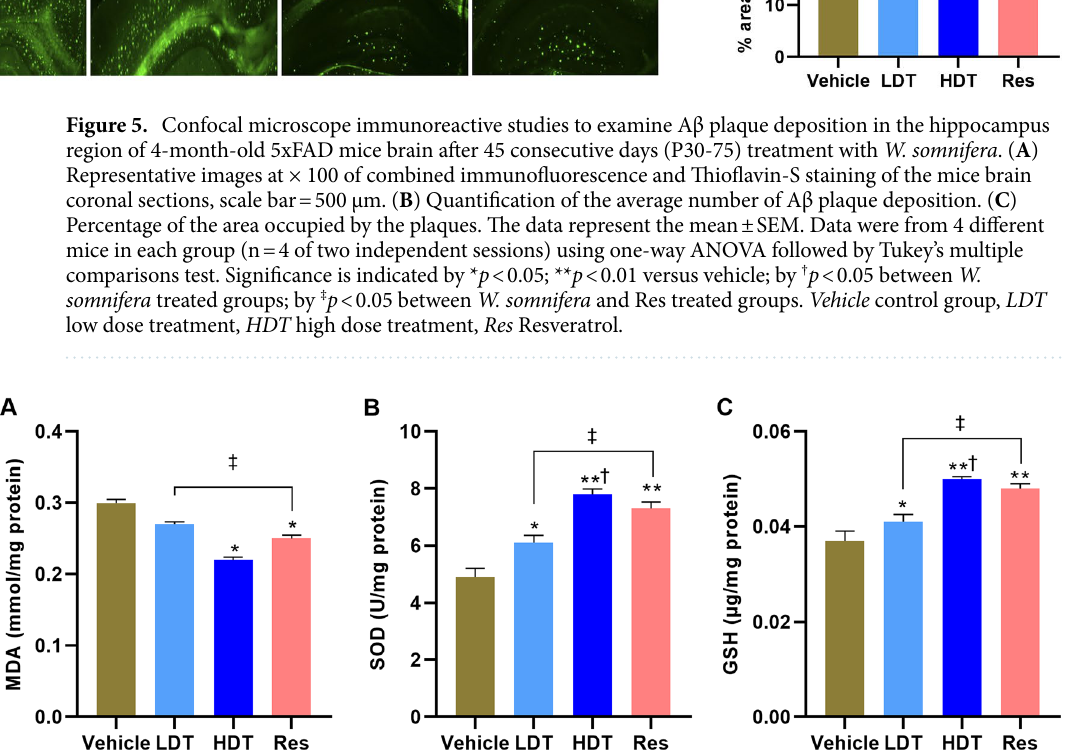
Figure 6. Antioxidant activity assay for the expression level of ( A ) MDA, ( B ) SOD, and ( C ) GSH in the brain tissue homogenates of 4-month-old 5xFAD mice after 45 consecutive days (P30-75) treatment with W. somnifera . The data represent the mean ± SEM. Data were from 4 different mice in each group (n = 4 of two independent sessions) using one-way ANOVA followed by Tukey’s multiple comparisons test. Significance is indicated by * p < 0.05 and ** p < 0.01 versus vehicle; by † p < 0.05 between W. somnifera treated groups; by ‡ p < 0.05 between W. somnifera and Res treated groups. MDA malondialdehyde, SOD superoxide dismutase, GSH glutathione, Vehicle control group, LDT low dose treatment, HDT high dose treatment, Res vehicle group brain was determined reversed with the administration of treatments ( p < 0.01 verses W. somnifera higher dose and the Res-treated mice). And the decreased levels of SOD and GSH in the vehicle group were ameliorated by the interventions ( p < 0.05 versus W. somnifera lower dose; p < 0.01 versus W. somnifera higher dose and the Res-treated mice). And remarkably, there were no notable differences in the oxidative stress nor- malization effects of the W. somnifera higher dose and Res treatments.